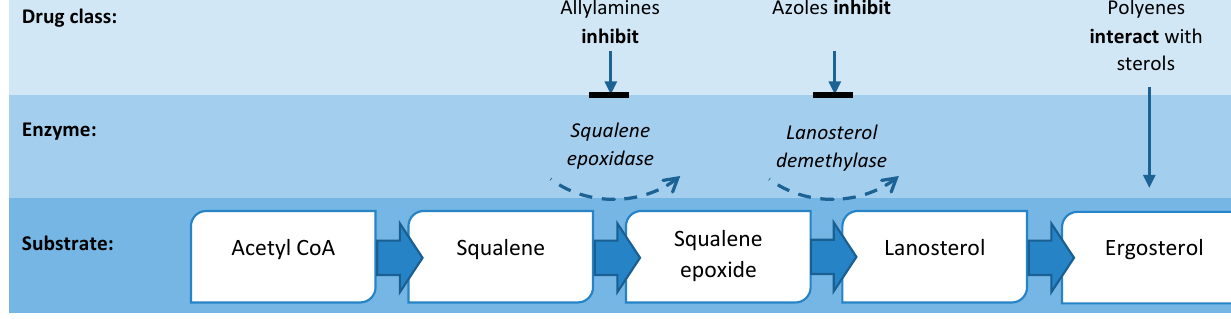
Figure 2: The ergosterol synthesis pathway, showing where the different classes of antifungal drugs exert their effects.